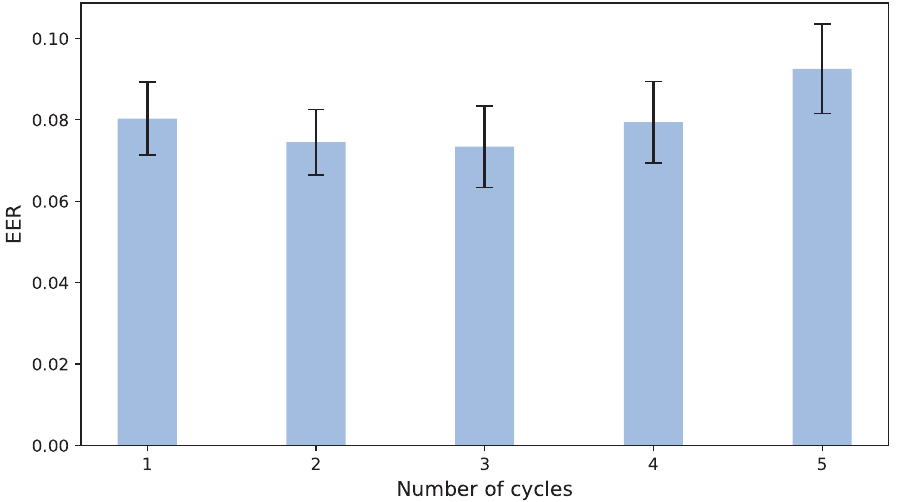
Figure 6. The average error rate under different number of cycles.